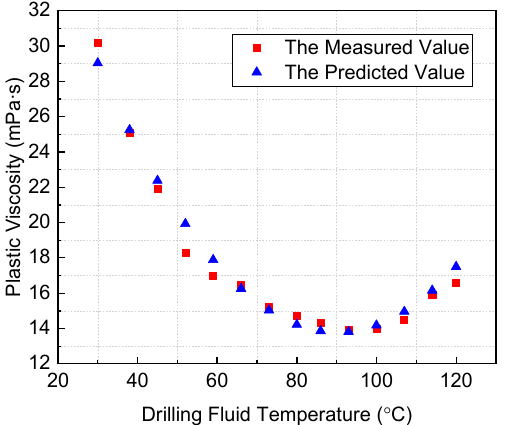
Figure 7. Comparison of predicted and measured plastic viscosity of drilling fluids. Based on the above experimental parameters, Clark and Fontenot conducted wellbore swab/surge pressure testing experiments under different conditions. One set of the drill string tripping speed and surge pressure measurement results at a well depth of 4591 m is shown in Figures 8 and 9. The input speed was 0.7584 m/s, and the maximum value of the surge pressure was 9.3579 MPa.